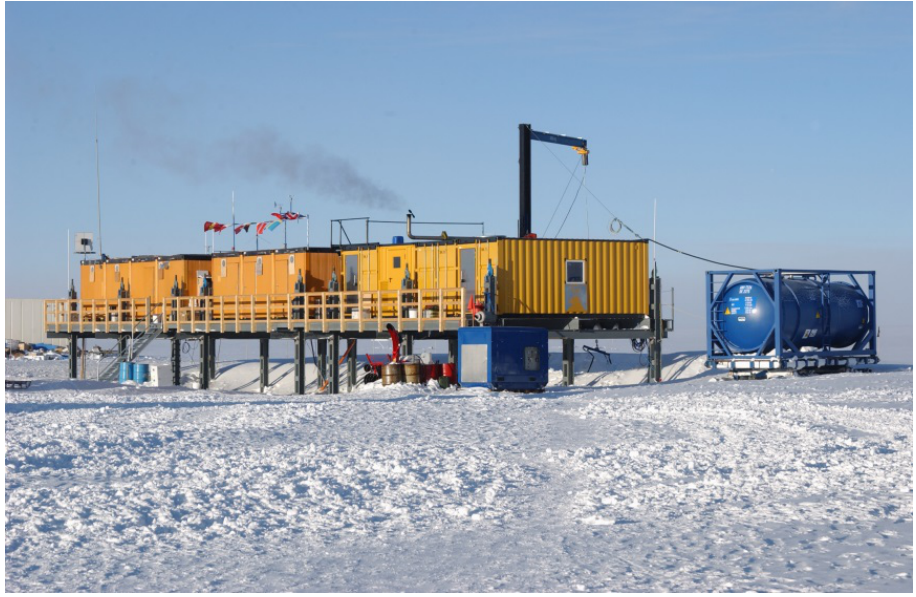
Figure 2: Kohnen Station. Photo: Alfred-Wegener-Institut/H.